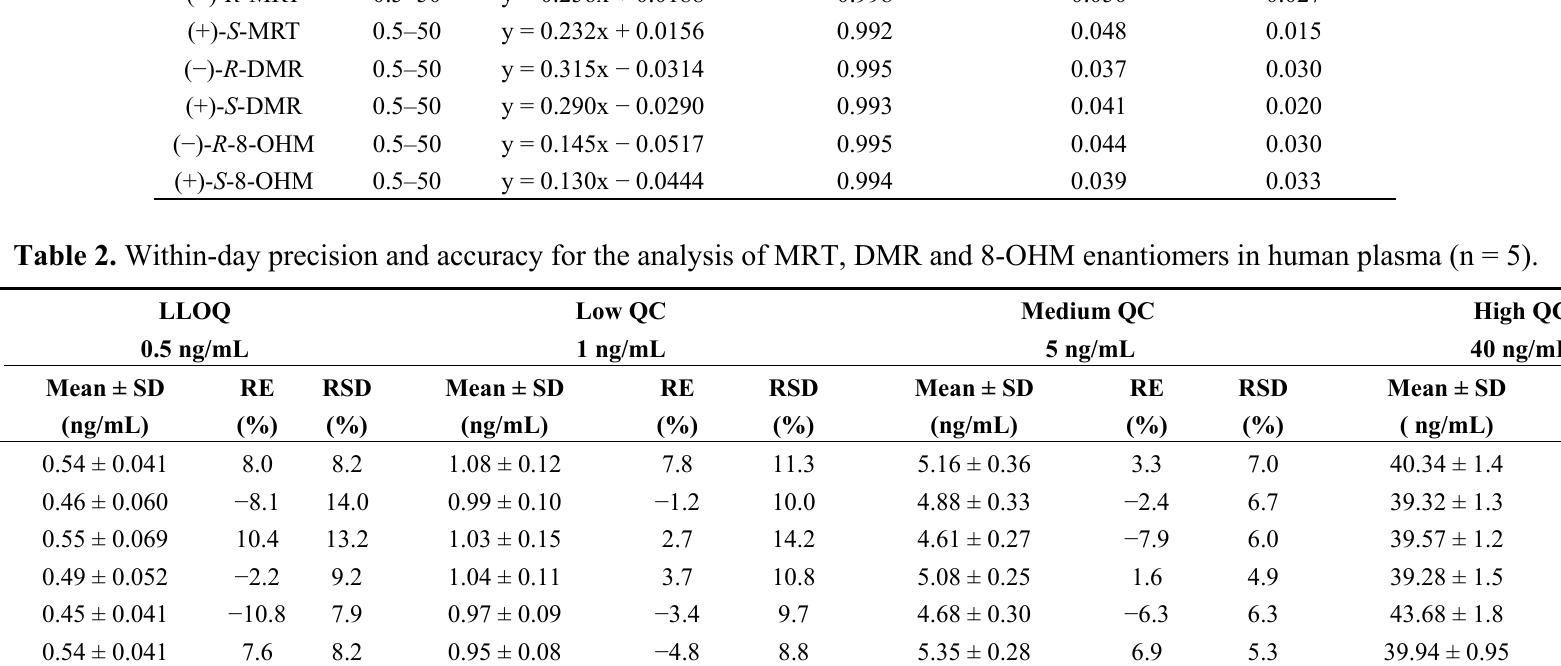
Table 1. The calibration equations for the determination of MRT, DMR, 8-OHM enantiomers (n = 3). Enantiomer Regression Equations